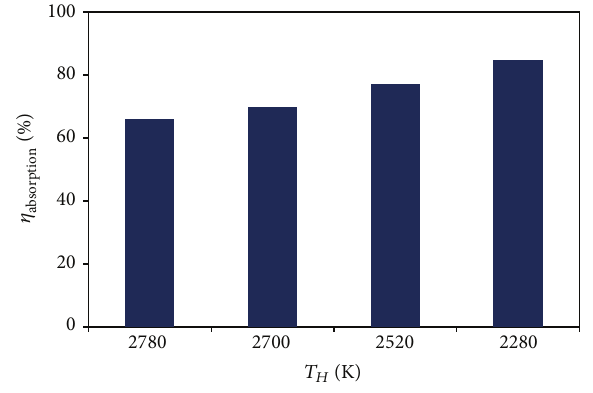
Figure 6: Effect of 𝑇 𝐻 on 𝜂